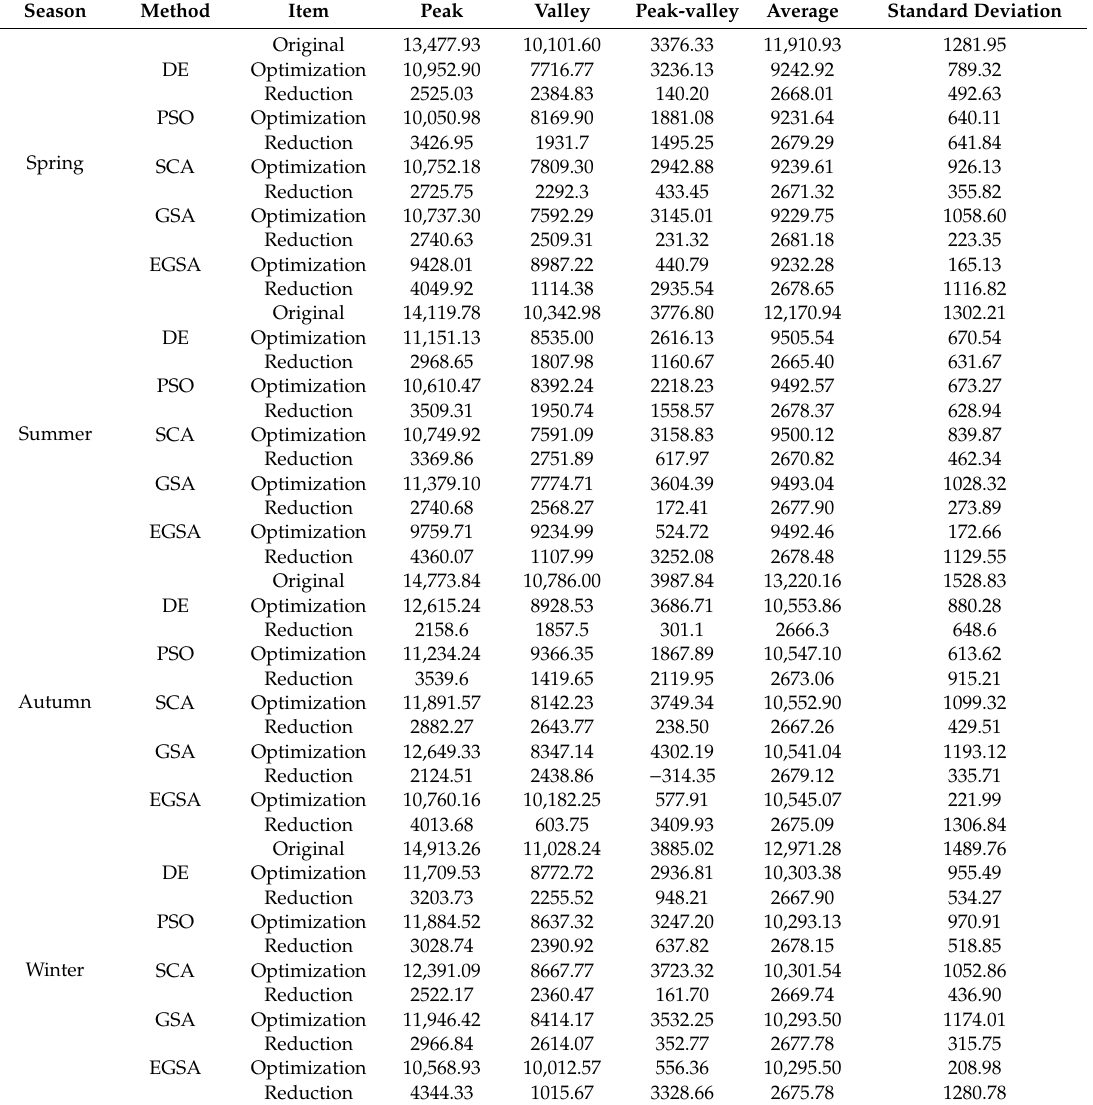
Table 8. Detailed results in the best solutions as obtained by the di ff erent methods